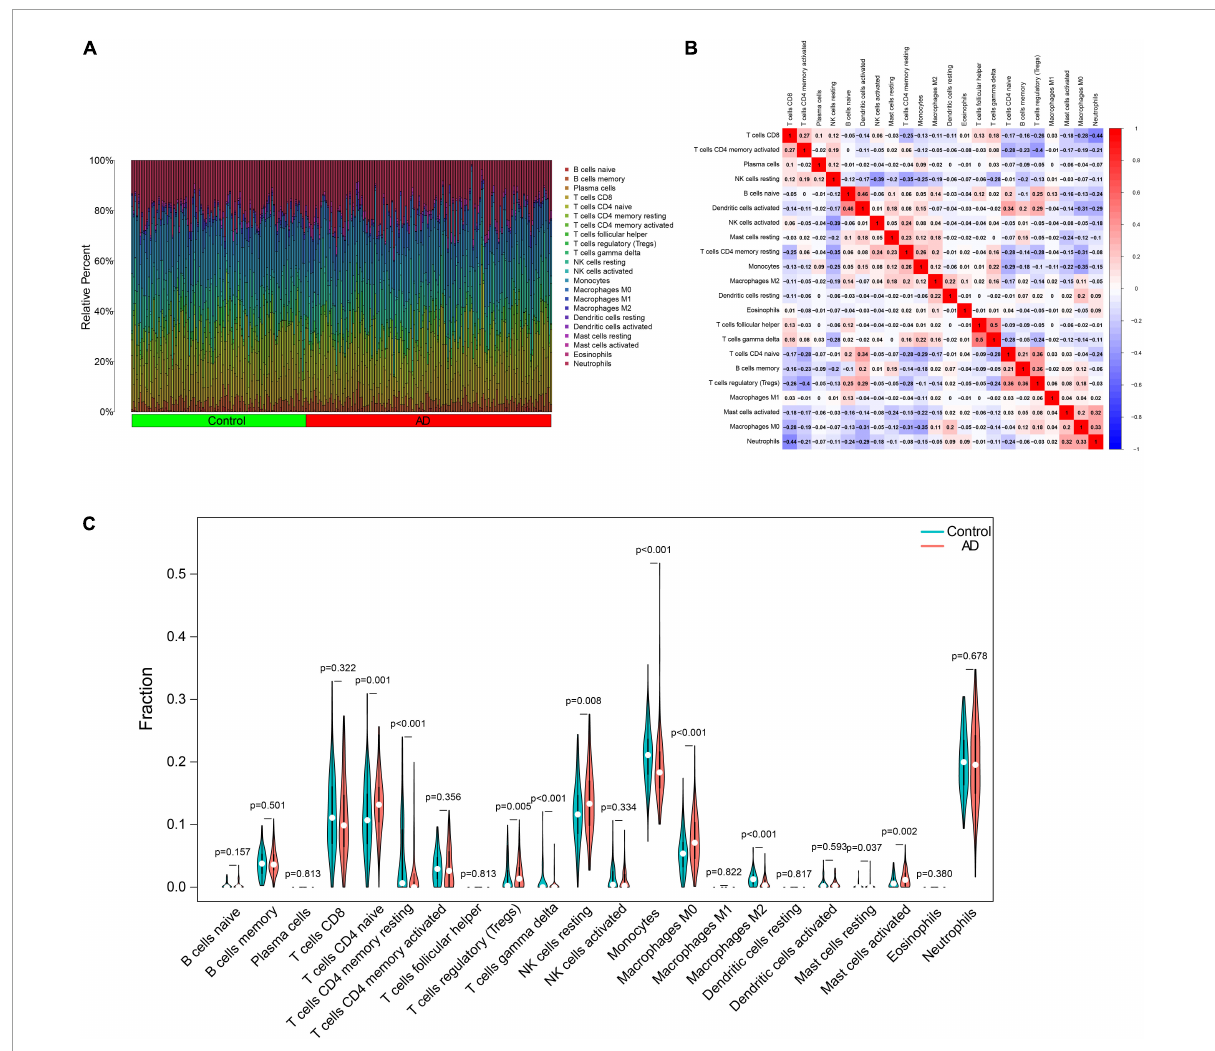
FIGURE8 Characteristics of immune cell infiltration. (A) Proportions of 22 types of immune cells. (B) Heatmap of the correlation among 22 types of immune cells. (C) Differential immune cell infiltration between AD and control groups. AD, Alzheimer’s